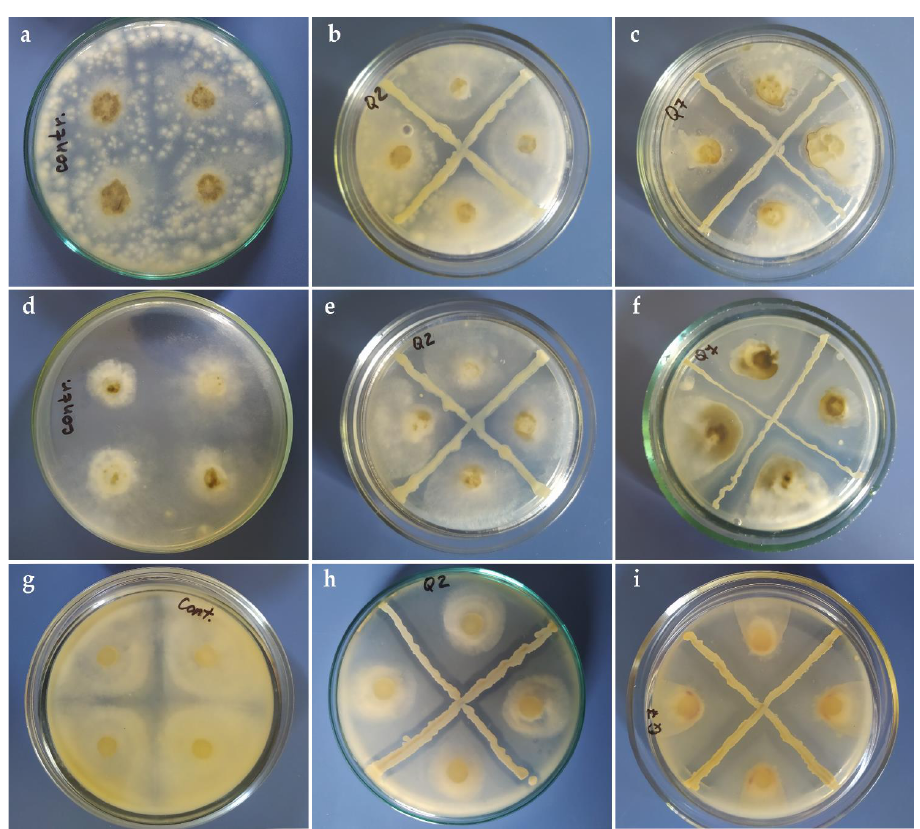
Figure A1. Results of testing the fungistatic action of endophytic bacteria Bacillus subtilis (Q2) ( і ) — Bacillus amyloliquefaciens (Q7) in relation to: ( а – с ) — Botrytis cinerea , ( d – f ) — Sclerotinia sclerotiorum , ( g – i ) — Fusarium tricinctum .